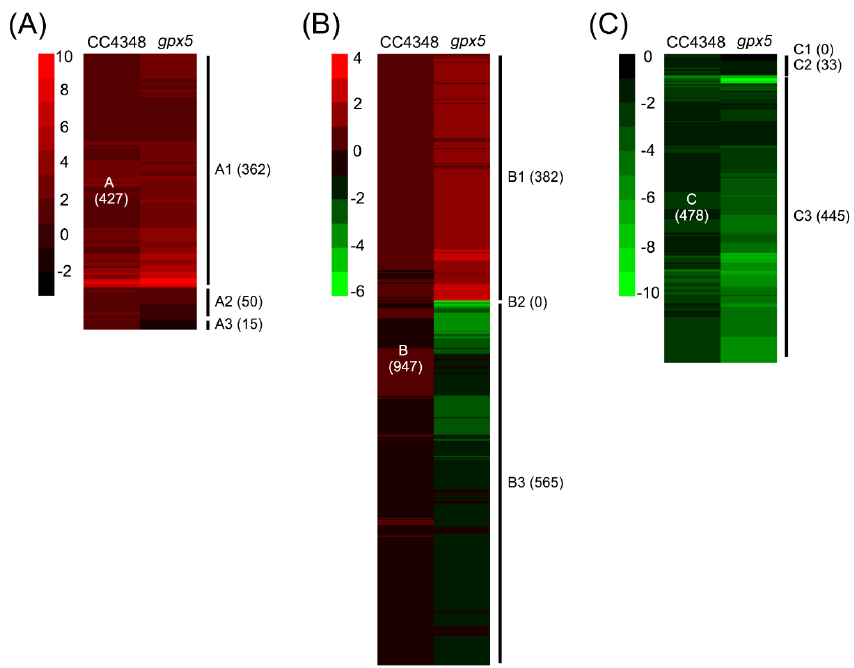
Figure 5. Comparison of the transcriptional response of CC4348 versus the gpx5 mutant after treatment with 1 µ M RB for 30 min. The cluster diagrams depict the fold change in transcript levels